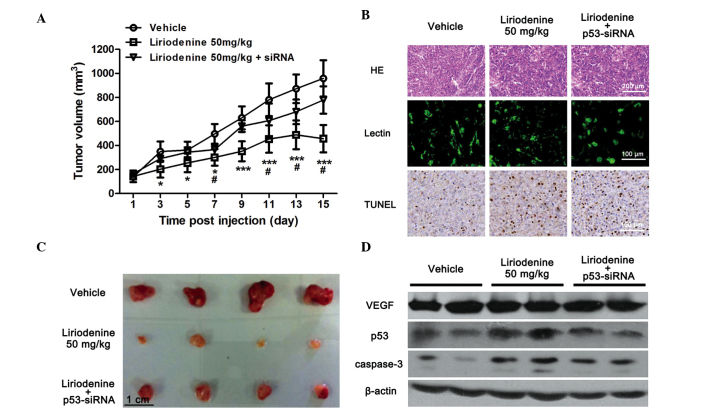
Liriodenine attenuates the rate of tumor growth in HEp-2-transplanted nude mice via the upregulation of p53 expression. (A) Tumor volume was measured every two days and calculated according to the formula described in the Materials and methods section. *P<0.05 and ***P<0.001 in liriodenine alone-treated group compared with the vehicle-treated group (n=8). #P<0.05 in the liriodenine-p53-small interfering RNA (siRNA)-treated group compared with the vehicle-treated group (n=8). (B) Macroscopic appearance of tumor tissues removed from each group. Scale bar referring to all panels, 1 cm. (C) Morphological analysis of tumor tissues. Following treatment, tumor tissues from vehicle-, liriodenine- and liriodenine-p53-siRNA-treated nude mice were removed and sectioned. Hematoxylin and eosin staining revealing blue-stained nuclei and pink-stained cytoplasm. Green fluorescence revealing lectin-positive vessels. Brown nuclei revealing TUNEL-positive cells. Representative scale bars are indicated for each panel. (D) Western blot analysis revealing the expression level of vascular epidermal growth factor (VEGF), p53 and cleaved caspase-3 in the tumor tissues following treatment. β-actin was used as the internal control. Each blot was repeated three times from tissues obtained from different mice. TUNEL, terminal deoxynucleotidyl transferase dUTP nick end labeling.